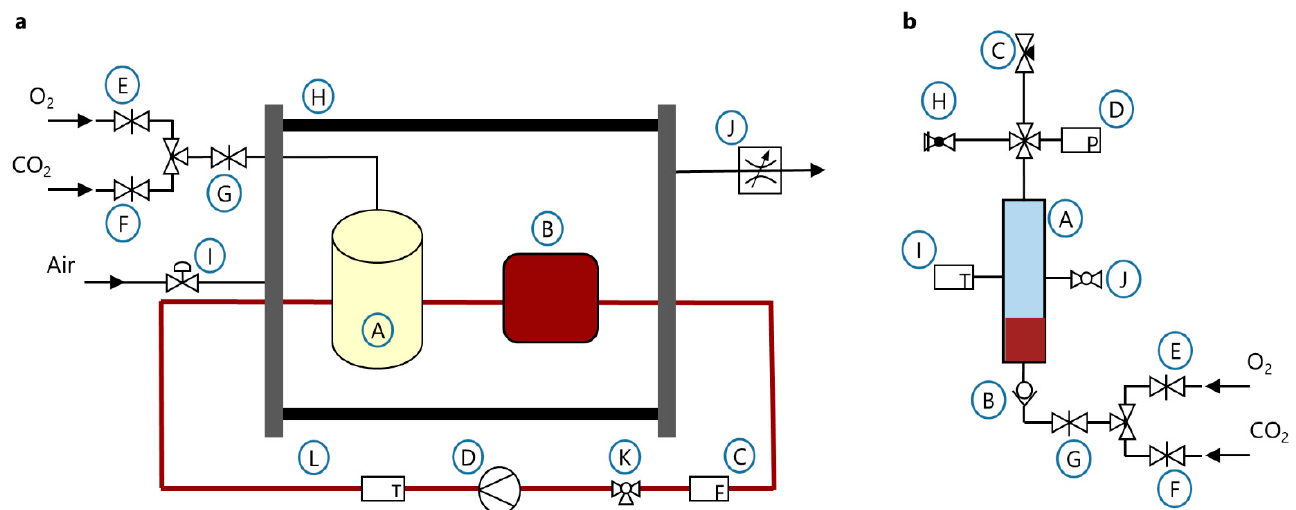
Figure 2. Experimental setups for the preliminary experiments ( a ) for the testing of a HFMO, ( b ) for the testing of a BO. Table 1. Test parameters for the preliminary